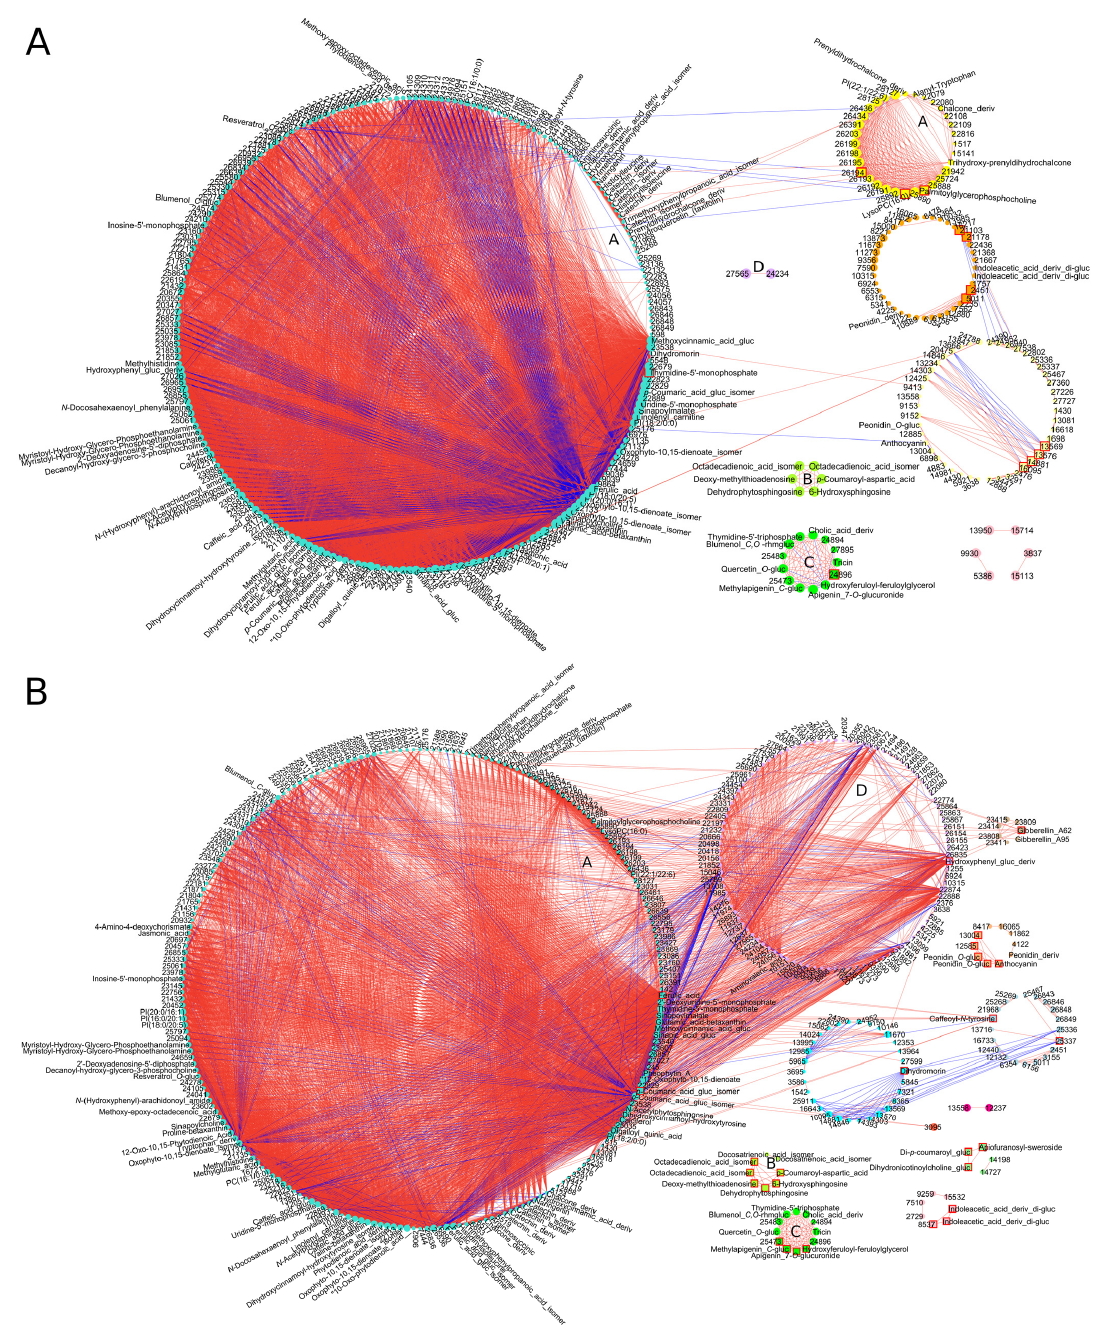
Figure 3. The correlation network of DAMs common for all genotypes observed ( A ) at T2 in control conditions, ( B ) at T2 after F. culmorum inoculation. Metabolites are represented by circles with numbers or annotated names. The size of the circle in a certain module is proportional to the number of edges/connections created by this compound and is scaled with respect to the vertex with the greatest number of edges in this module. Squares with a red border denote hubs, i.e., compounds with the highest number of connections. Edges link highly correlated DAMs. Modules of DAMs are visualized by different colors. Only edges corresponding to elements of the topological overlap matrix greater than 0.25 are shown, both within and between modules: red edges—positive correlations, blue edges—negative correlations. The modules with a large number of DAMs (>60%) occurring in both control and treatment are marked with letters ( A – D ). Abbreviation hex is for hexoside, deriv is for